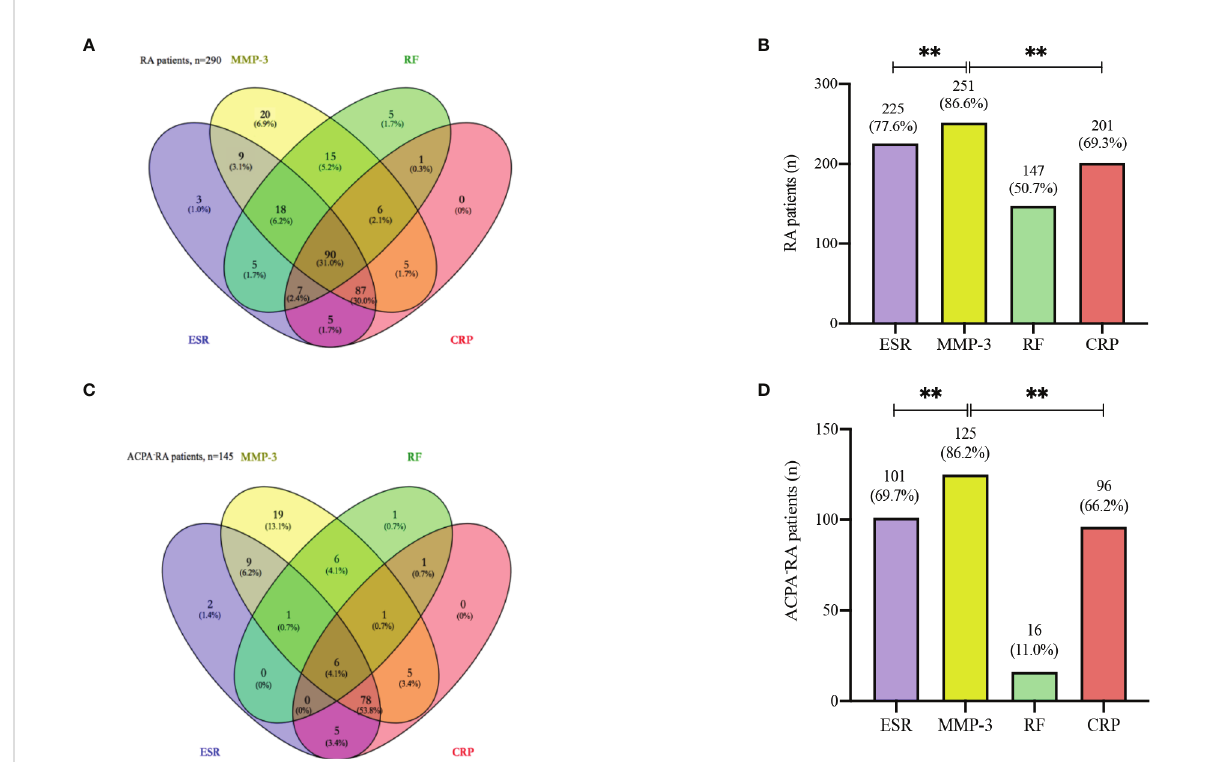
FIGURE 4 Venn diagram. (A) Venn diagram with number and percentage of positive results from the whole 290 RA patients. (B) The positive rate of each index in 290 RA patients. (C) Venn diagram with number and percentage of positive results from the 145 ACPA - RA patients. (D) The positive rate of each index in 145 ACPA - RA patients. ** p <